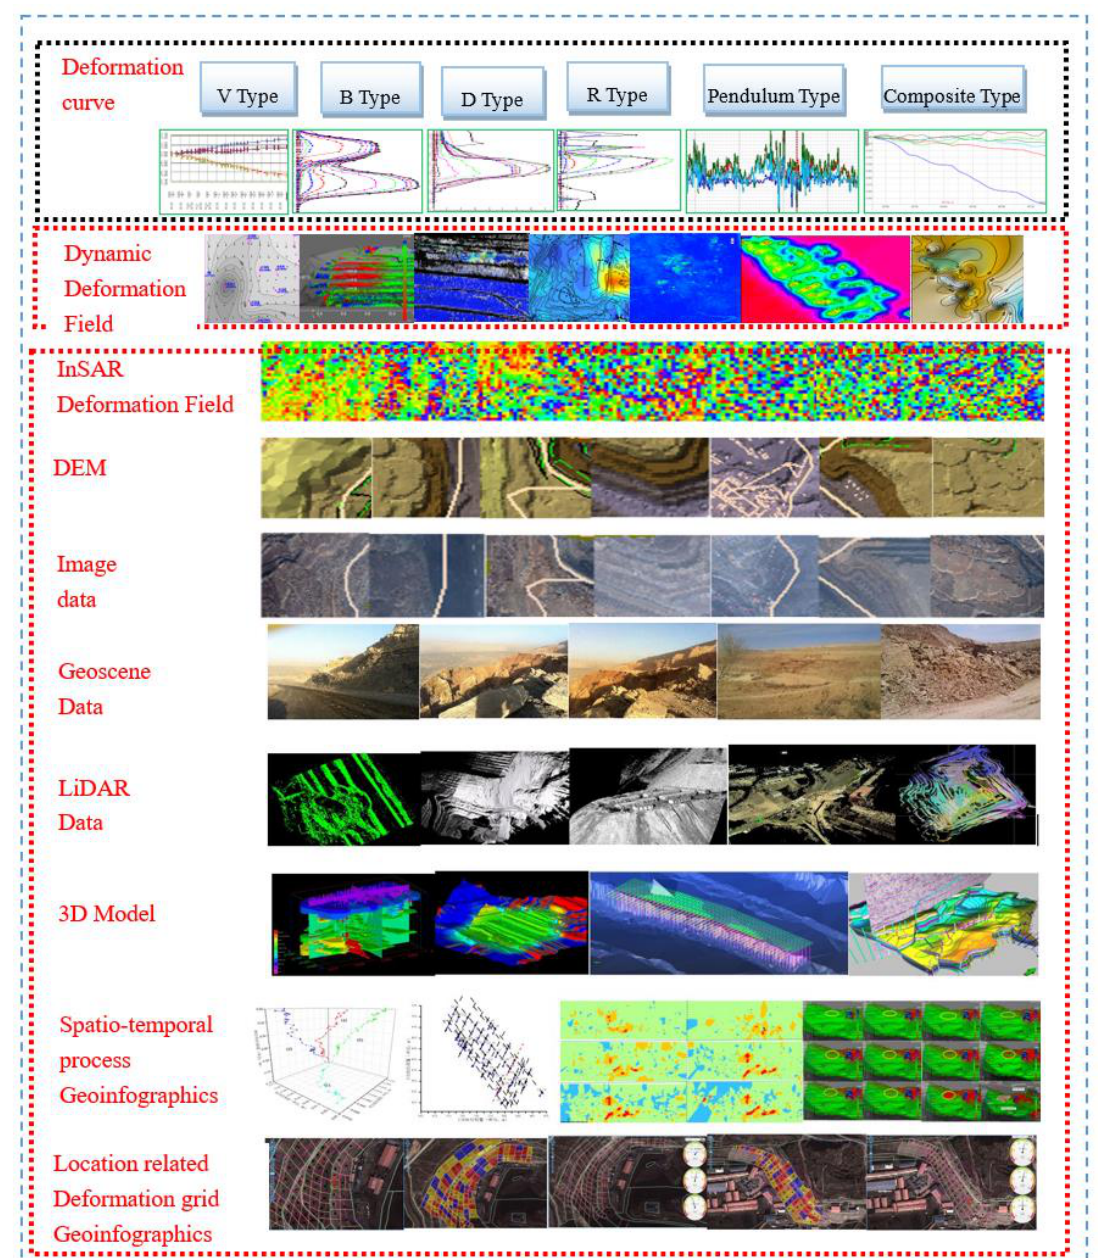
Fig. 4 Representation of multi-field Geo-infographics Spectrum of Surface Geohazards in mining